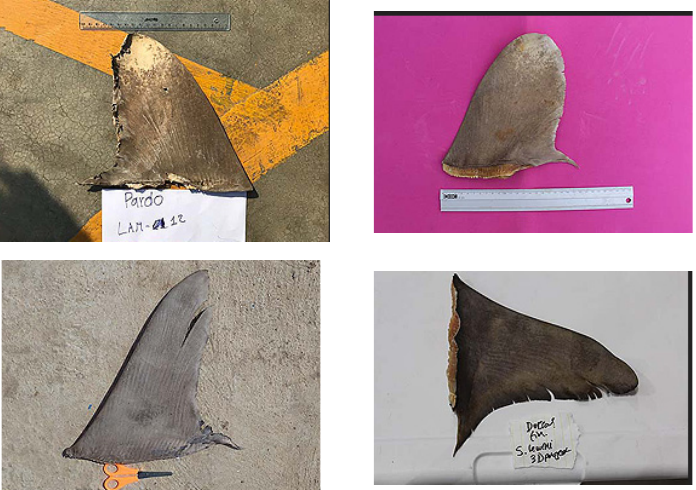
Figure 2. Dry dorsal fins shark database with noise in the background. In the four images we can see different objects, lines, and colors, which may hinder correct identification.